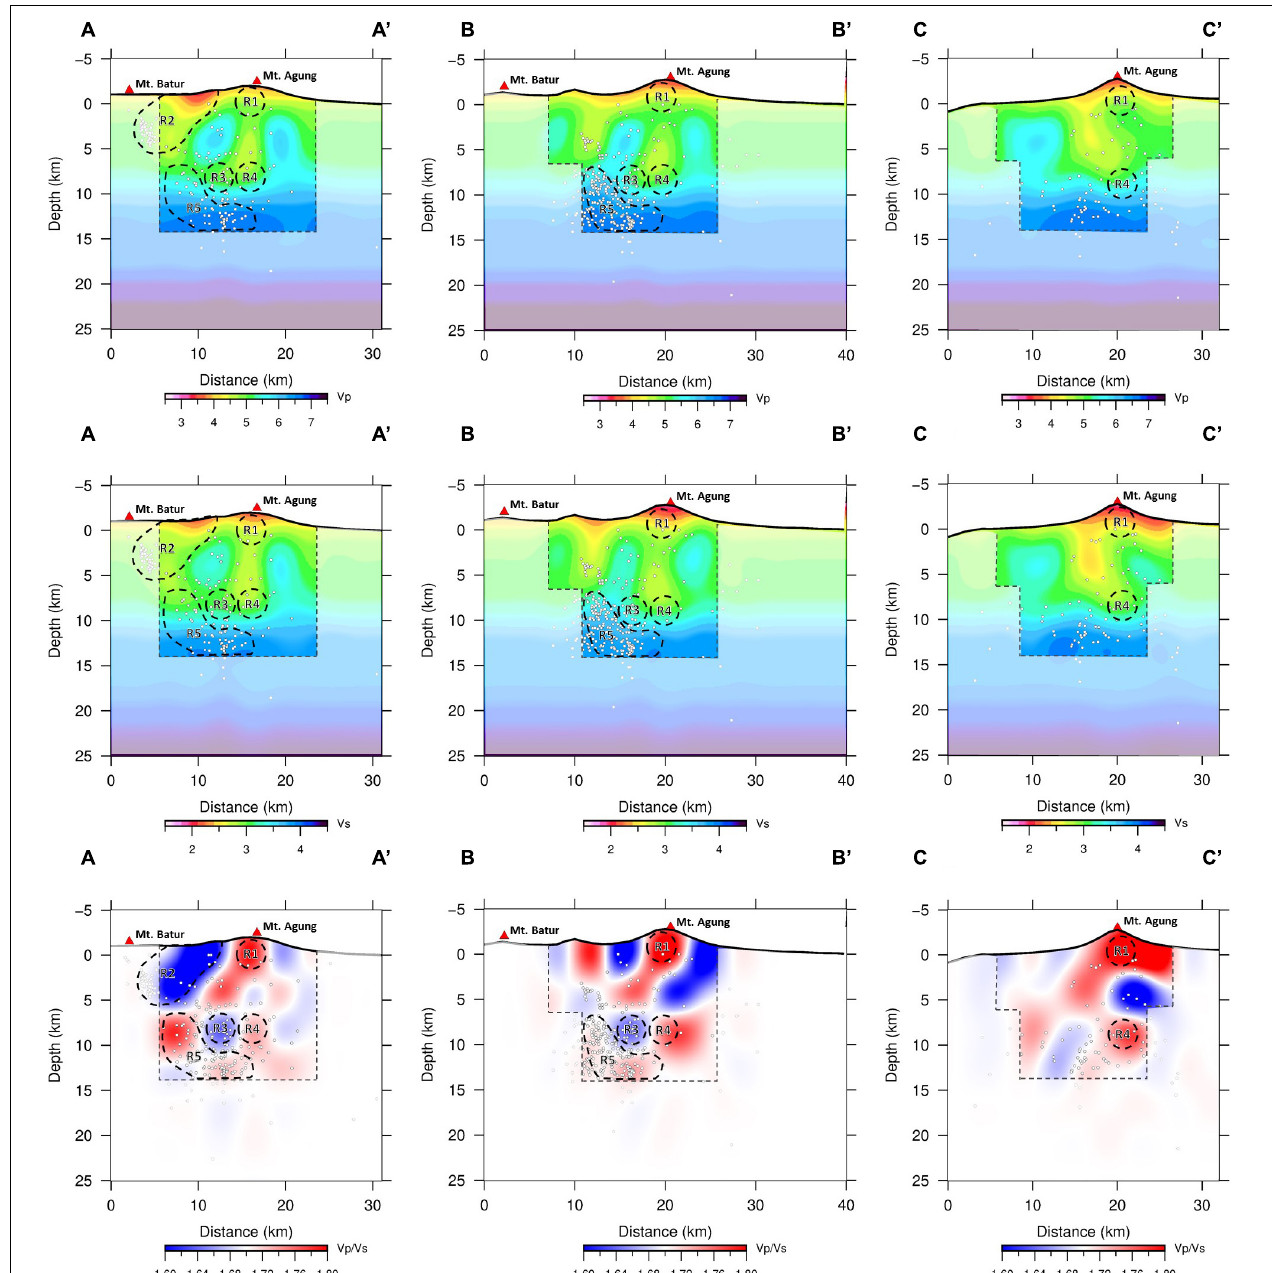
FIGURE 4 | The vertical cross-sections of the Vp, Vs, and Vp/Vs models from top to bottom, respectively; for slice (A-A’) (first column), (B-B’) (second column), (C-C’) (third column), the spatial location of each cross-section can be seen in Figure 1C . Vp, Vs and Vp/Vs are plotted as absolute values. The white dot represents the hypocenter’s projection to the vertical cross-section; only events with depths less than 0.5 km from the centerline are plotted here. Dashed black lines define the area which has a good resolution based on resolution test results. Labeled regions (R1–R5) depicted by these figures are discussed in the